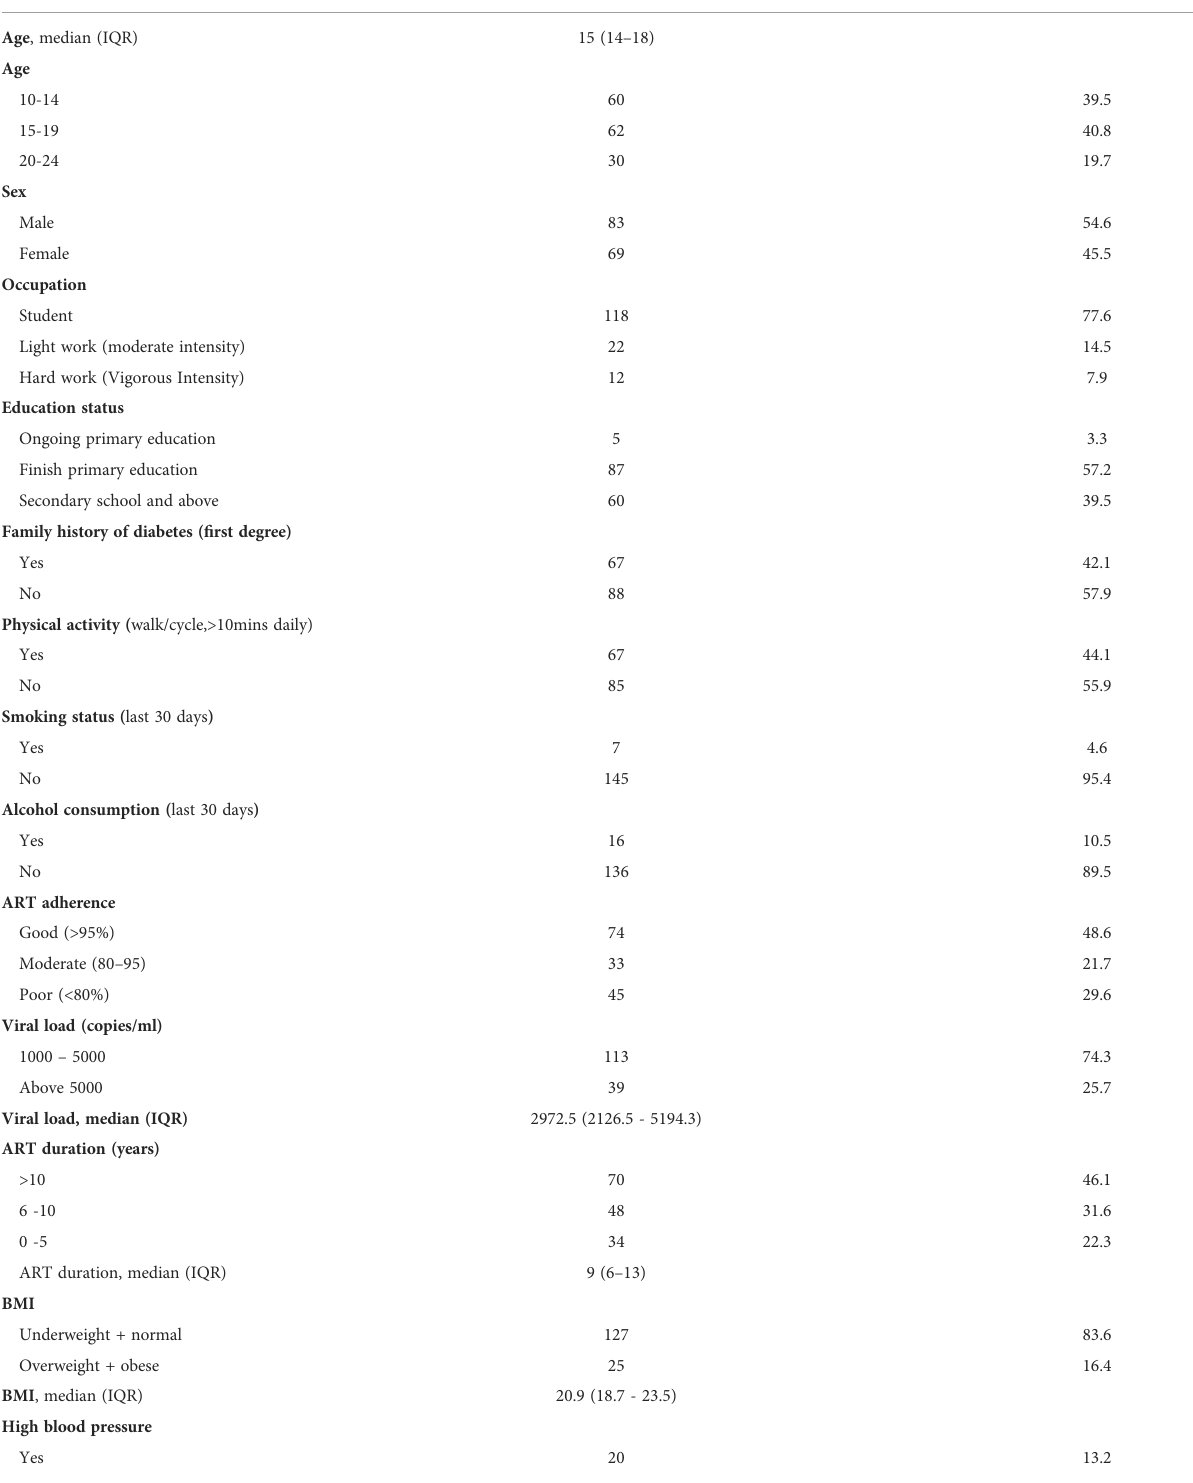
TABLE 1 Characteristics of study participants